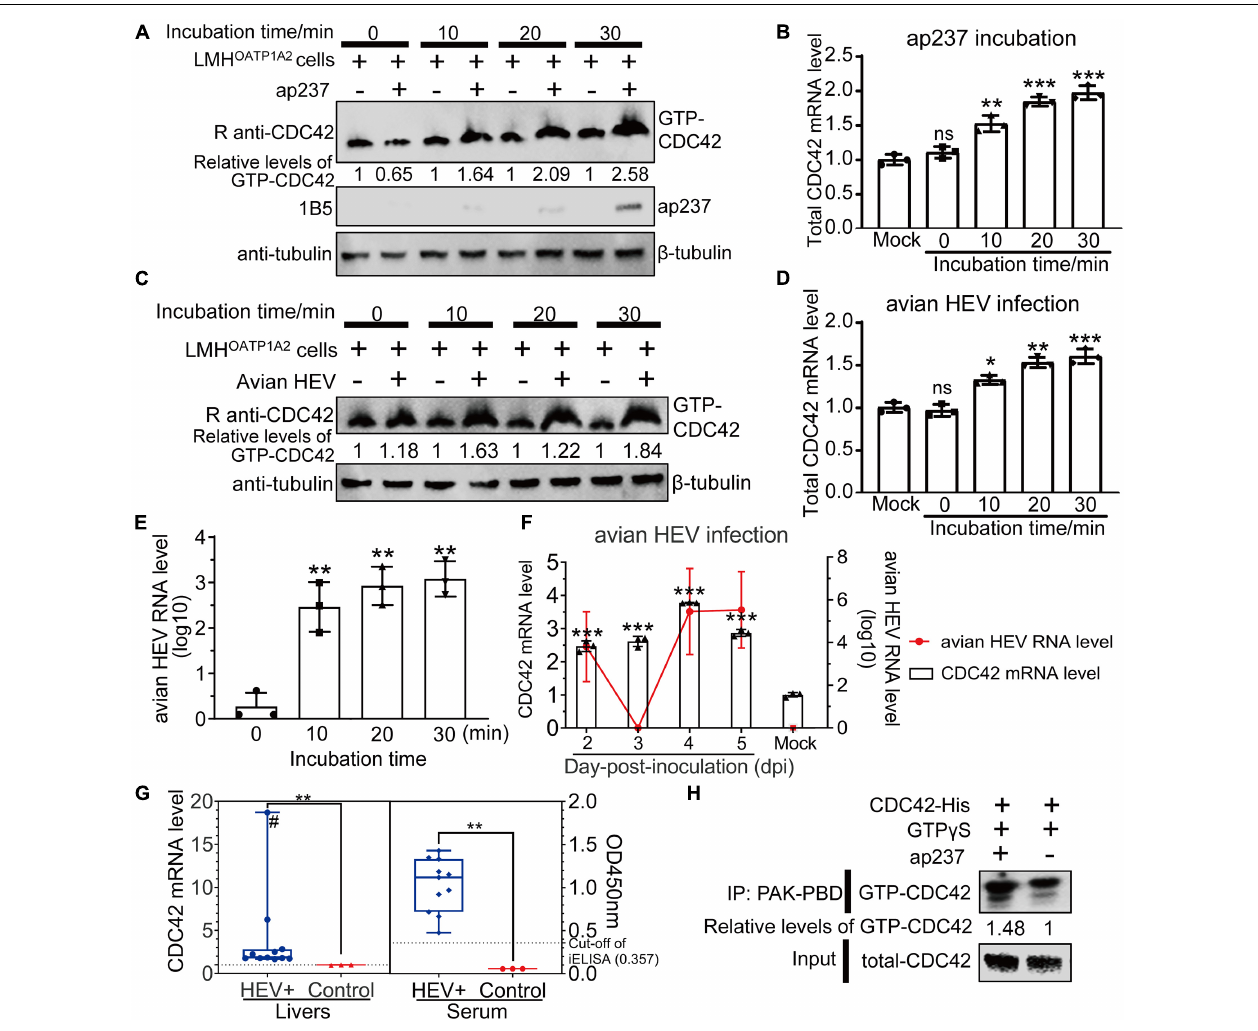
FIGURE 2 | Expression levels of total GTP-CDC42 and CDC42 in ap237 treated and CaHEV infected cells. (A,B) Expression levels of GTP-CDC42 and mRNA of total CDC42 in the LMH OATP1A2 cells treated with ap237 for 0, 10, 20, and 30 min. (A) Lysates of each group were incubated with PAK-PBD beads to pull down GTP-CDC42, then the beads were washed twice and immunoblotted with rabbit anti-CDC42 pAb. β -tubulin was employed as an internal control. (B) The relative RNA levels of the total CDC42 of each group were determined by qPCR. (C,D) Expression levels of GTP-CDC42 and mRNA of total CDC42 in the LMH OATP1A2 cells inoculated with CaHEV for 0, 10, 20, and 30 min. (E) The amounts of avian HEV by qPCR in LMH OATP1A2 cells at 0, 10, 20, and 30 min-post-inoculation. (F) CDC42 mRNA levels in liver tissues from chickens inoculated with CaHEV at 2, 3, 4, and 5 dpi. (G) Relative mRNA levels of CDC42 in CaHEV-positive chicken livers (left panel) and anti-avian HEV IgG levels in sera corresponding to CaHEV-positive chicken livers (right panel). The symbol “#” means that the value is a straggler. (H) CDC42 binding more GTPs through interaction with ap237 in vitro . The mixtures of CDC42-His and ap237 or only CDC42-His were incubated with GTP γ S at room temperature. After stopping the reaction, the samples were immediately added to 10 µ g of PAK-PBD beads and incubated at 4 ◦ C for 1 h, and beads were washed twice and analyzed by Western blotting. CDC42 mRNA levels were normalized to avian GAPDH. ns, no significant; * P < 0.05; ** P < 0.01; *** P < 0.001.